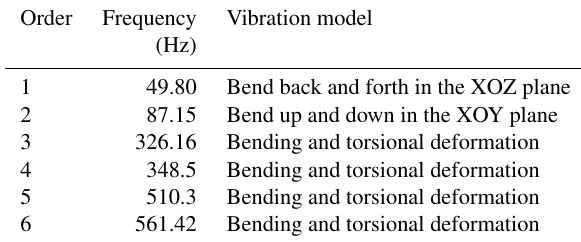
Table 4. Performance comparison before and after forearm opti- mization.